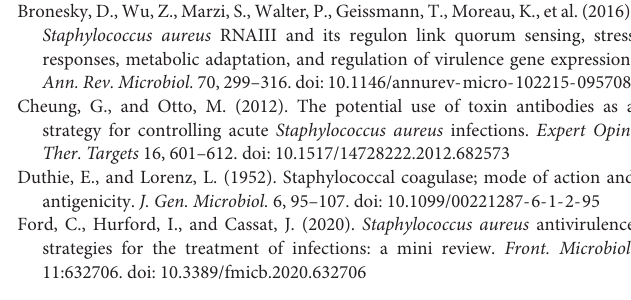
Supplementary Figure 1 | The amino acids comparisons of AgrB (A) , AgrD (B) , and AgrC (C) among the four S. aureus agr allelic strains: agr I (Newman), agr II